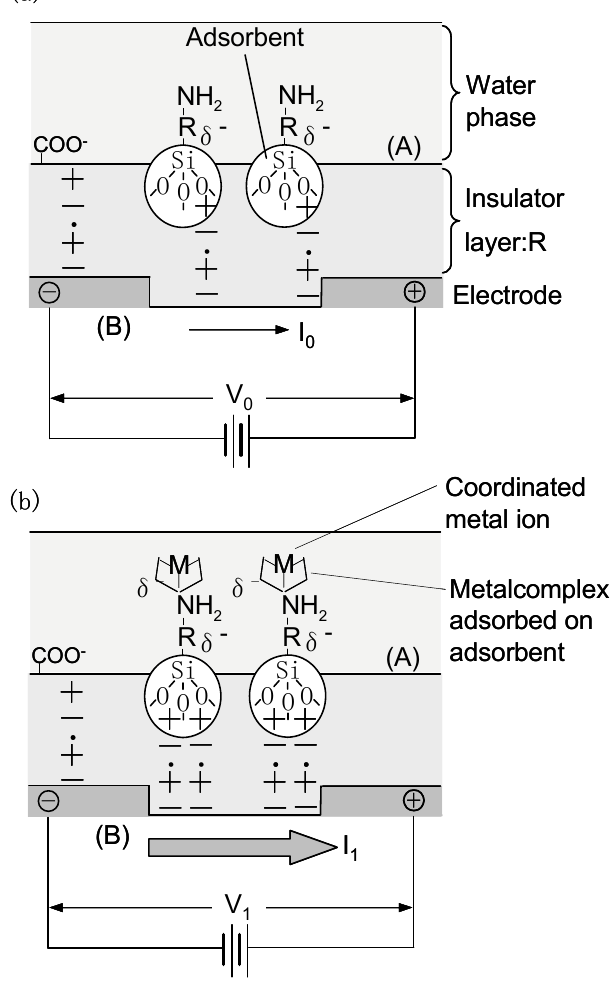
Figure 1. Schematic of an electrode chip and the detection mechanism of chemisorbed